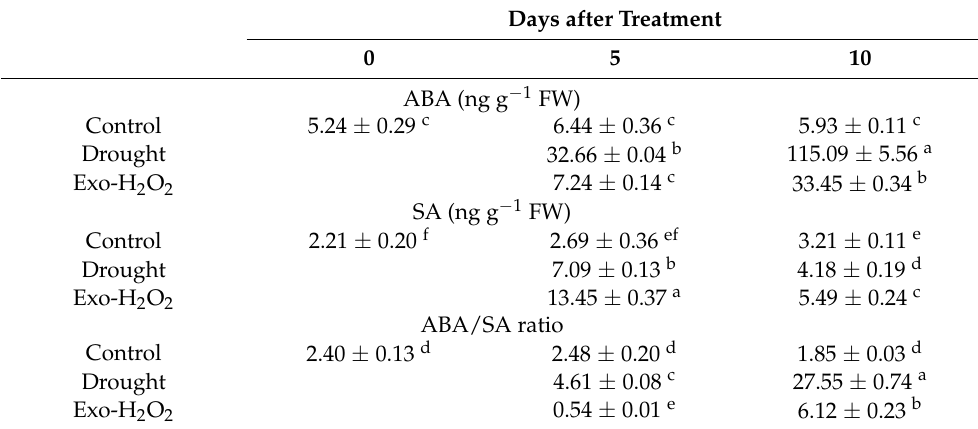
Table 2. The changes in levels of endogenous abscisic acid (ABA) and salicylic acid (SA), and in the ratio of ABA to SA under control, drought, or exogenous H 2 O 2 (Exo-H 2 O 2 ) treatments for 10 days. Days after Treatment